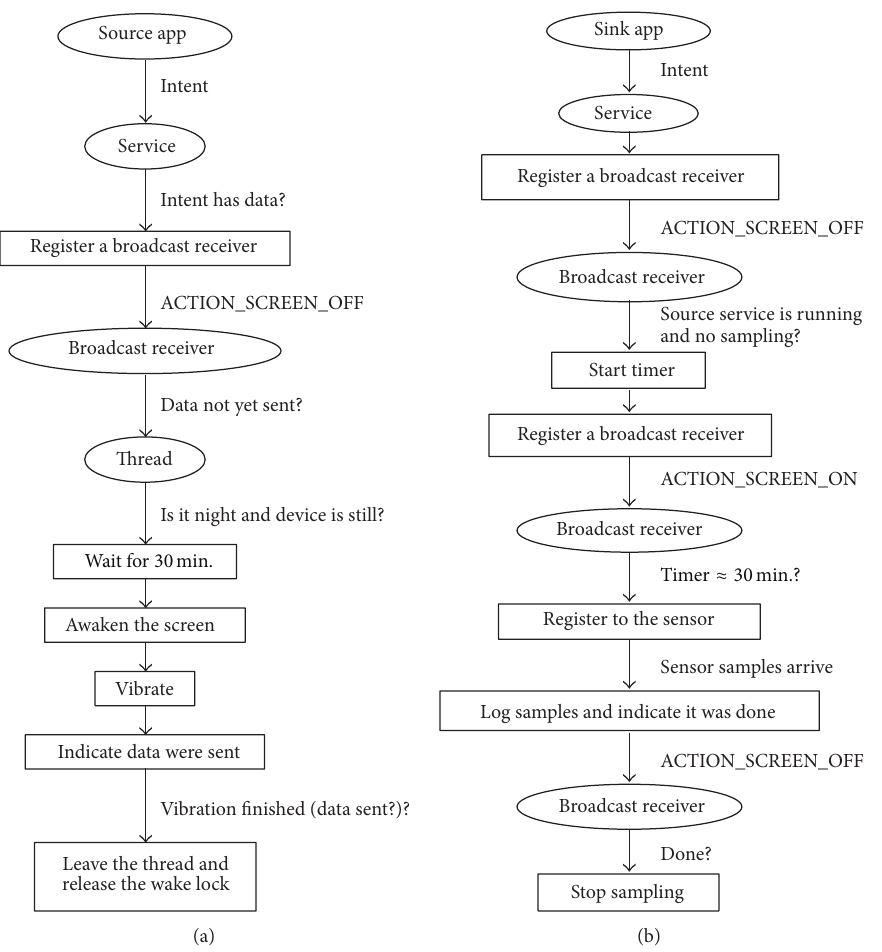
Figure 5: Logic flows in algorithms of the (a) source application and (b) sink